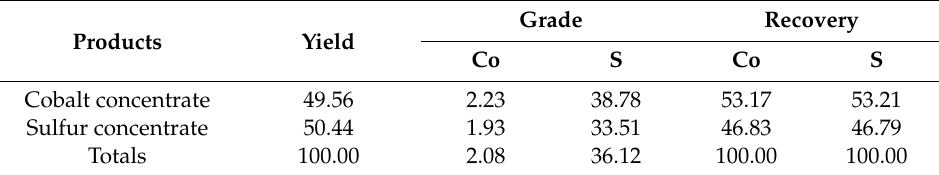
Figure 11. Cobalt and sulfur separation test flowsheet of cobalt–sulfur concentrate. Table 7. Results of cobalt and sulfur separation in flotation